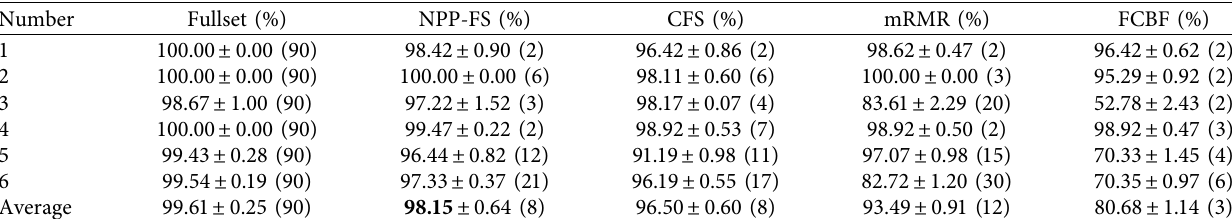
Table 5: Comparison of feature selection algorithms under SVM